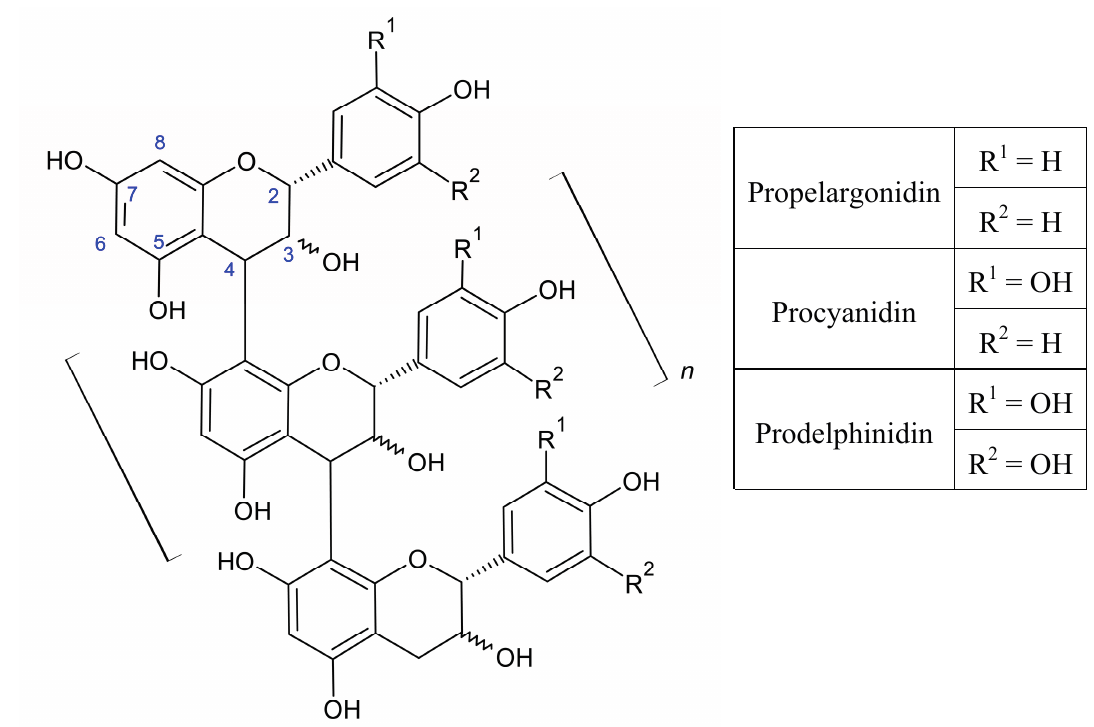
Figure 1. Proanthocyanidin polymer structure and monomeric flavan-3-ol